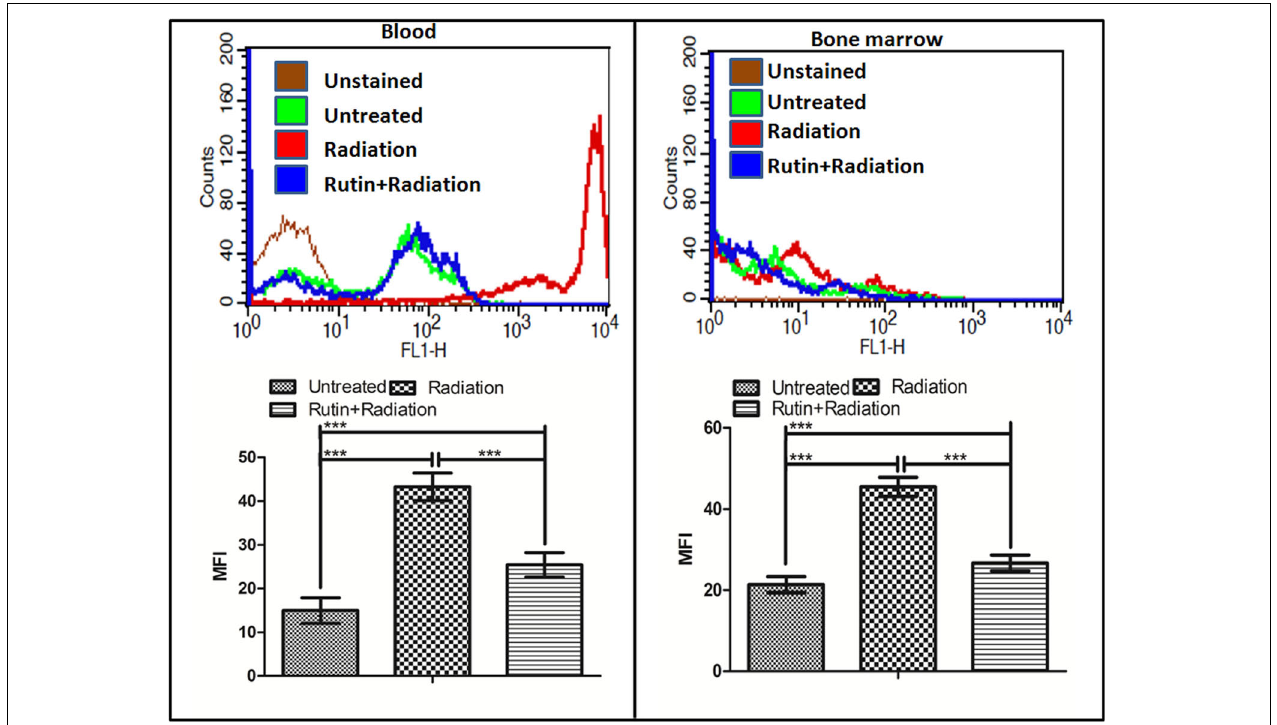
FIGURE 3 | ROS scavenging ability of rutin in the blood and bone marrow cells: The graph and the histogram shows the radiation induced ROS scavenging property of the compound rutin at 1 h time point in blood and bone marrow cells of mice. n = 6 per